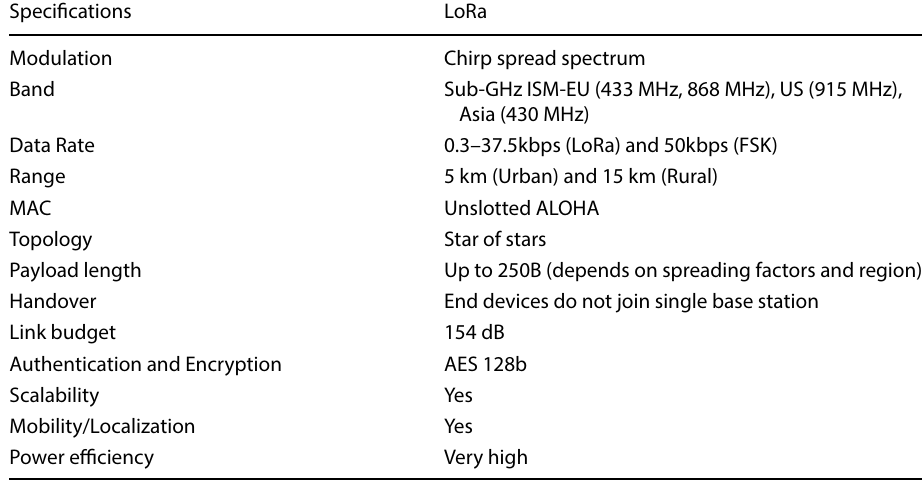
Table 2 Technical specifications of